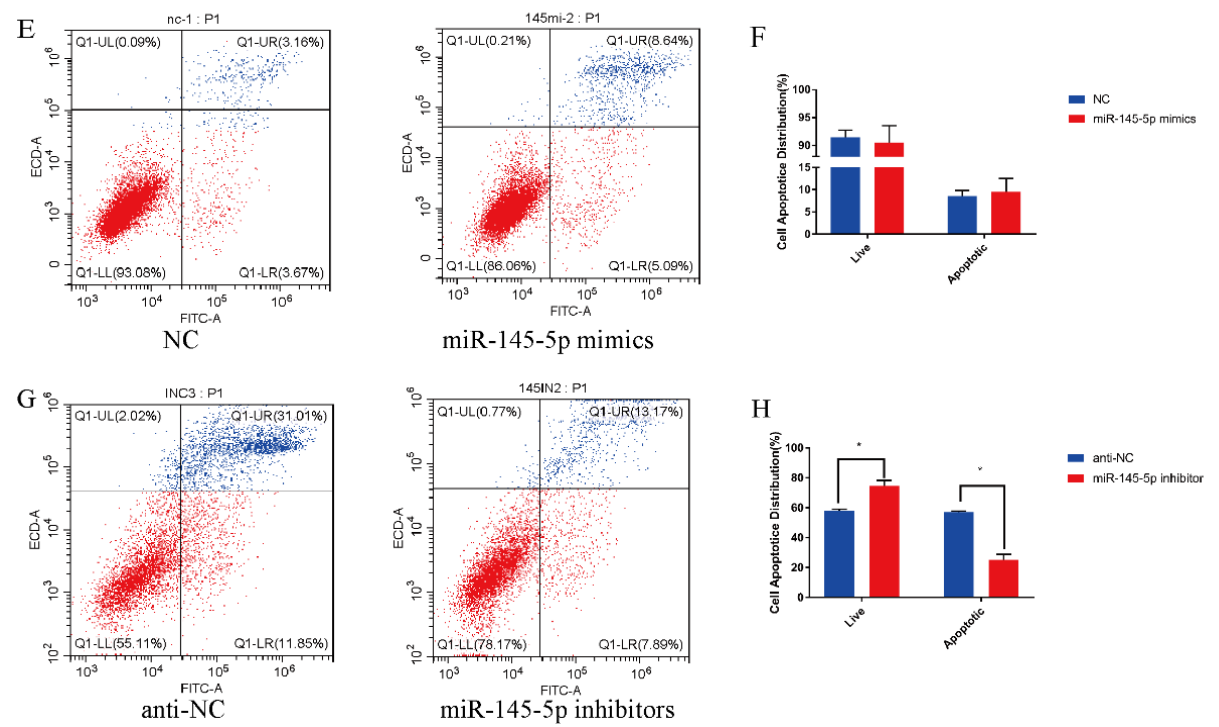
Figure 3. miR-145-5p regulates goat HFSC apoptosis. ( A ) RT-qPCR quantified the expression of marker genes ( BAX and BCL2 ) following miR-145-5p upregulation. ( B ) Western blotting showed the expression of proliferation marker genes following transfection with miR-145-5p mimics. ( C ) RT- qPCR was utilized to quantify the marker genes’ expression ( BAX and BCL2 ) following miR-145-5p downregulation. ( D ) Western blot analysis of the expression of proliferation marker genes following transfection with miR-145-5p inhibitors. ( E – H ) Distribution and proportion of apoptotic cells in the upgrade and knockdown groups. No asterisk, p > 0.05; *, p < 0.05; **, p < 0.01.